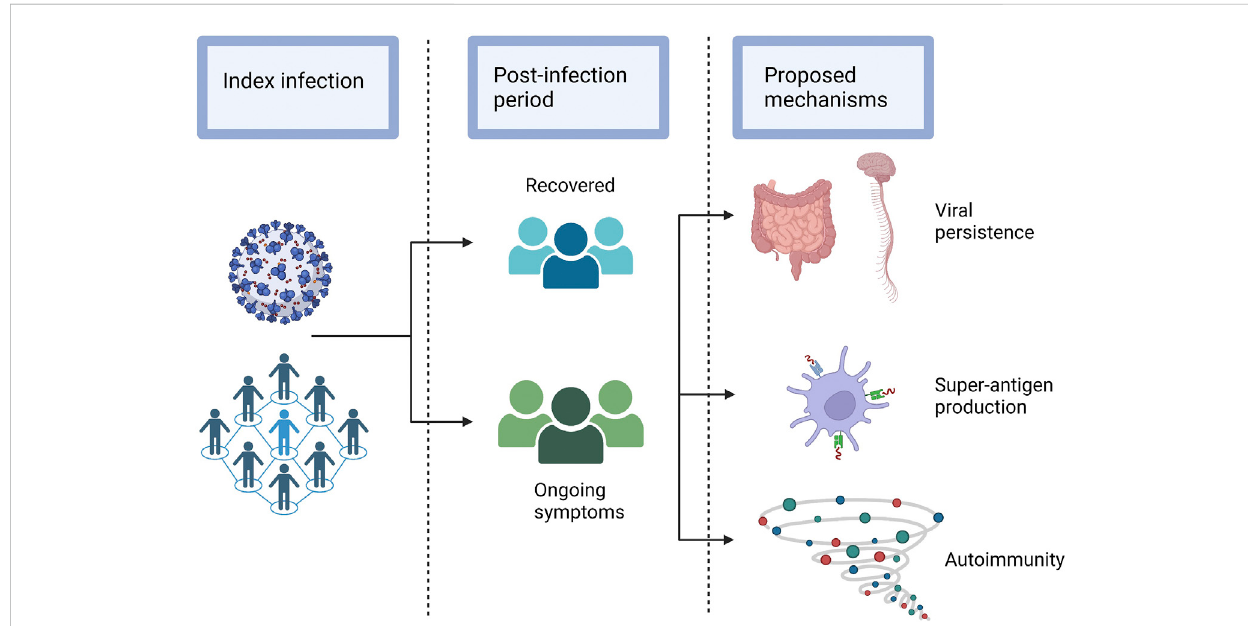
FIGURE 2 Hypothesised sequelae of SARS-CoV-2 that lead to long COVID. Legend: A selection of the possible sequelae of SARS-CoV-2 that may lead to the various post-acute pathologies that occur in a subset of